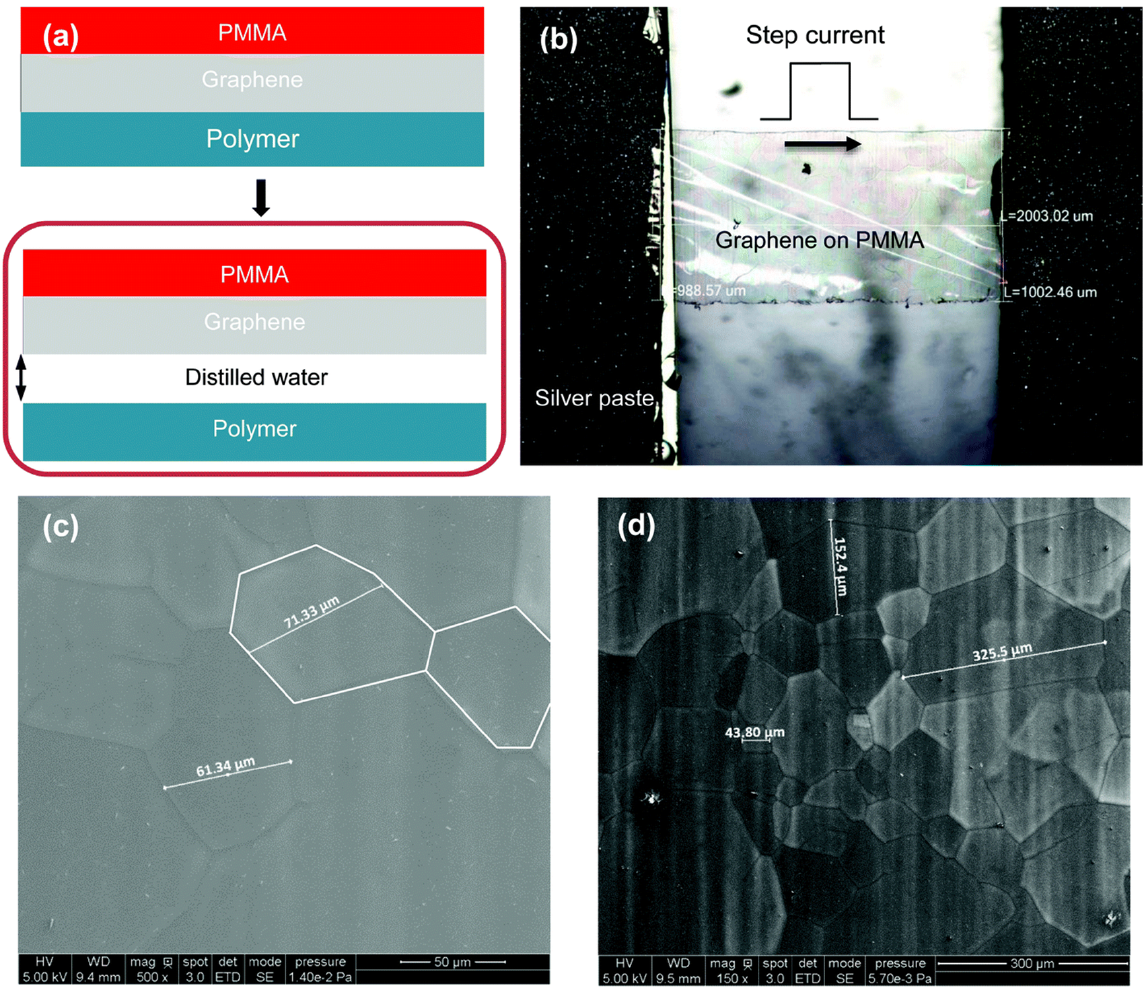
Figure 3. ( a ) Procedures for acquiring the sample of desired size from graphene. ( b ) Microscopic image of the graphene sample between the electrodes. ( c ) and ( d ) SEM images of the sample. The characteristic size of grains can be clearly seen in the range of tens to hundreds of microns. (Reproduced from Ref. [63] with permission from The Royal Society of Chemistry).